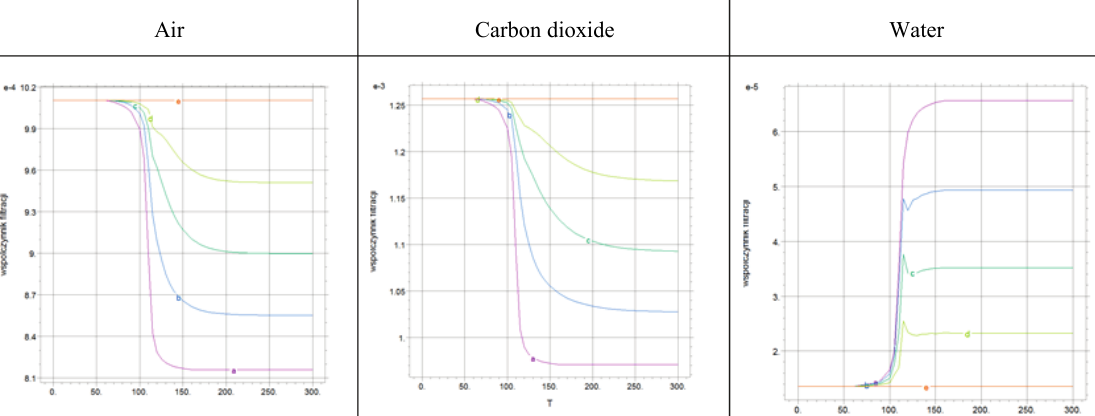
Table 6. Time course of the filtration coefficient